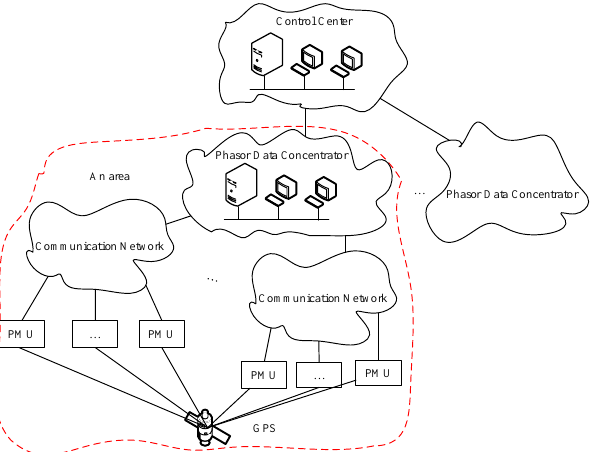
Figure 2. Structure of WAMS.